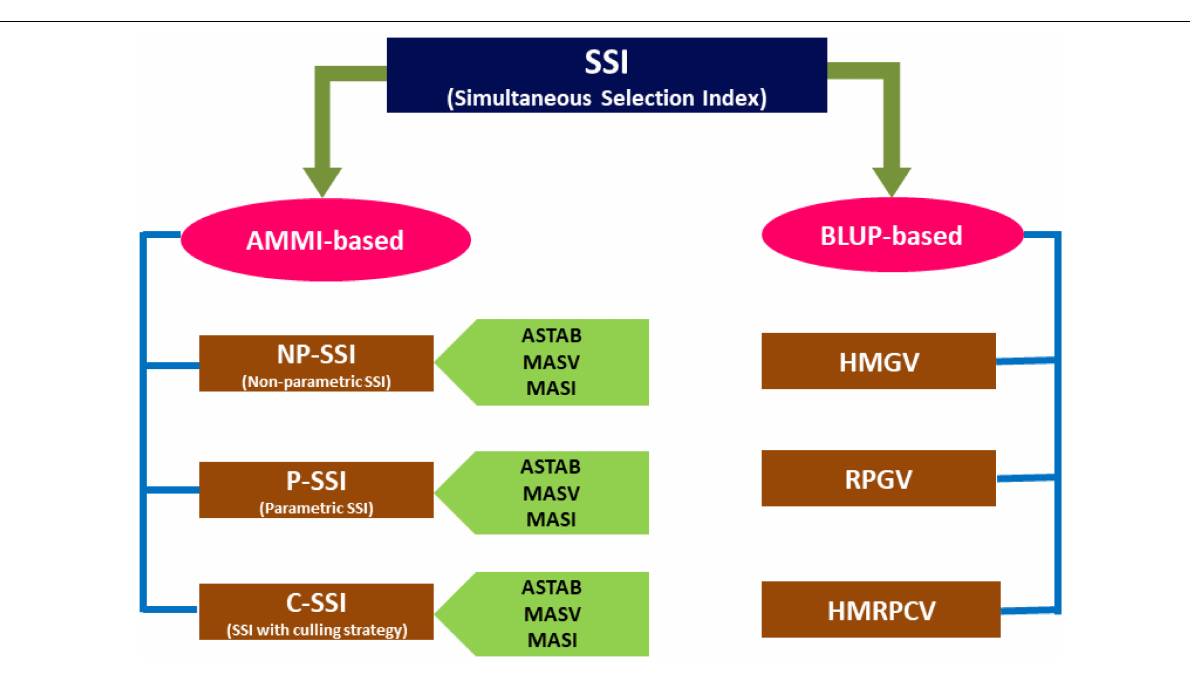
FIGURE 2 | Various approaches used for the simultaneous selection of finger millet genotypes evaluated during the six main seasons of